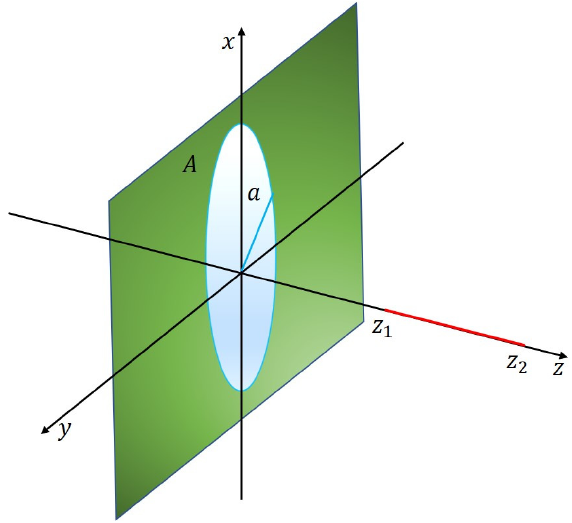
Figure 1. Geometry of the